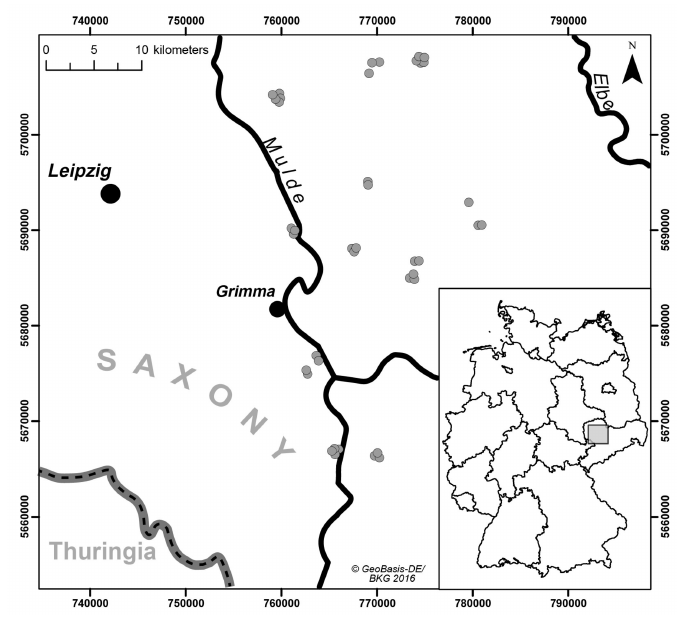
Figure 1. Overview of the study area in eastern Central Germany (State of Saxony) with soil sampling locations (coordinate system: UTM zone 32U, ETRS89).